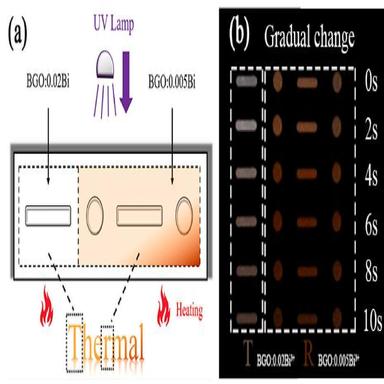
(a) Schematic diagram of the designed logos for expressing 'T, R = thermal' and (b) the thermal afterglow signals obtained by heating at 150 ◦C for interval 2s.